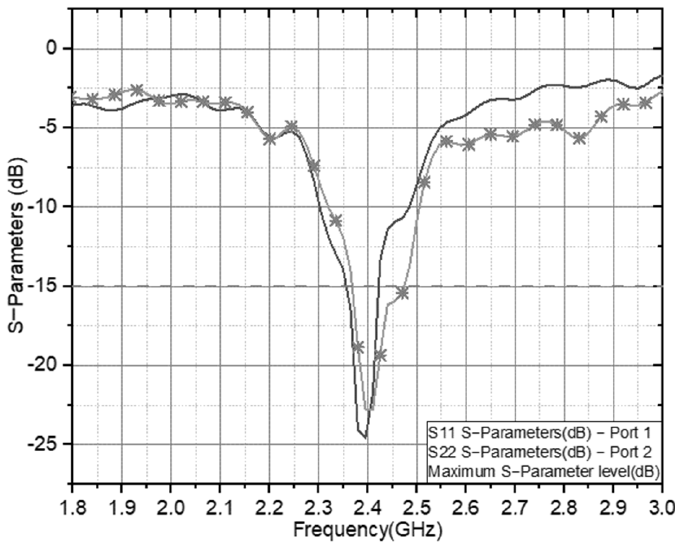
Figure 10. S Parameter of the Double U slot with a dual feed CP Antenna.